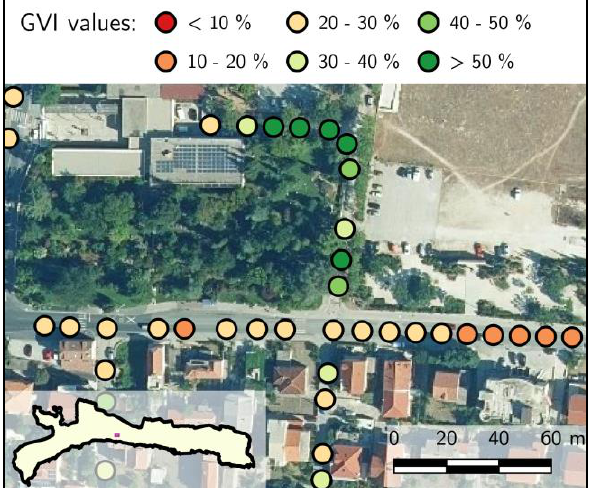
Figure 3. A closer look at the GSV acquisition sites (sites are colored by corresponding GVI value, aerial imagery © State Geodetic Administration of